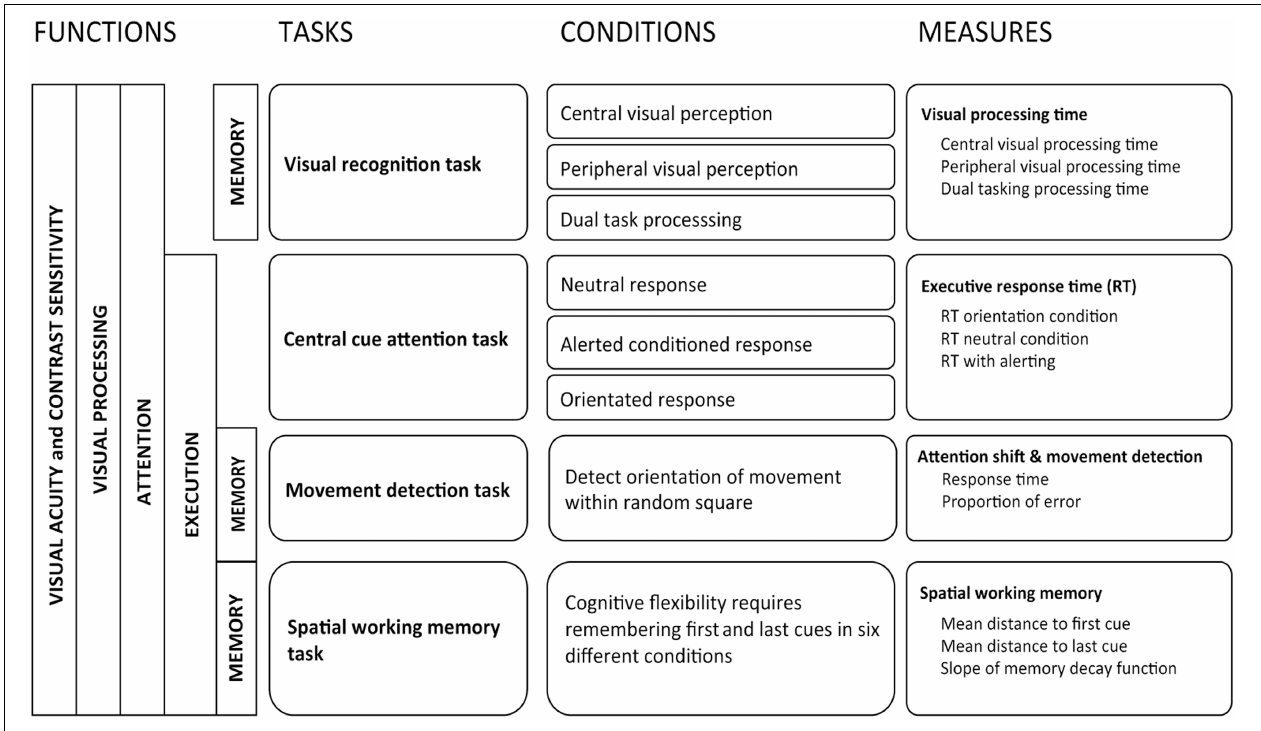
FIGURE 1 | Description of tasks and outcomes included in